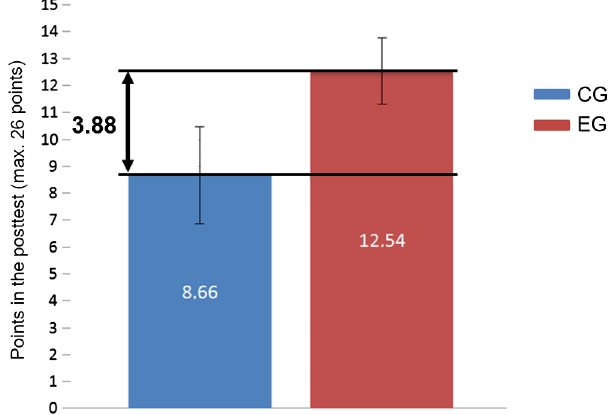
FIG. 16. Post-test results of the control group (CG) and experimental group (EG) with 95% confidence intervals. The pretest results were controlled for using hierarchical linear modeling. The statistically highly significant net effect of the treatment (3.88 points) is printed in bold. The highest achievable score in the test is 26